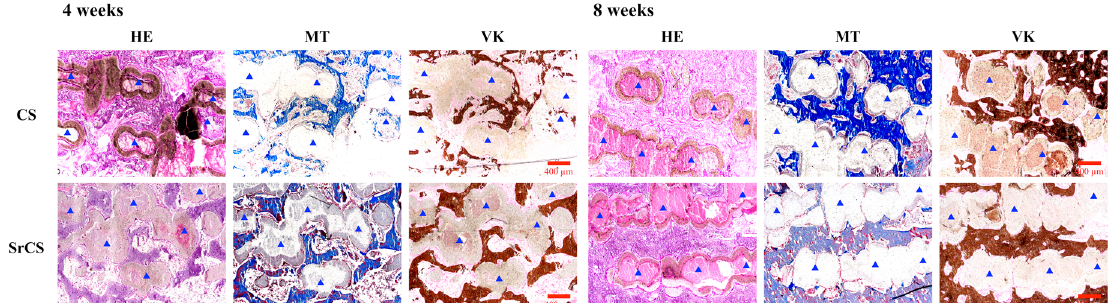
Figure 14. Histological analysis of new bone regeneration around and within the scaffolds in the rabbit femoral defect model. Left: hematoxylin and eosin (HE) stain; Middle: Masson’s trichrome (MT) stain; Right: Von Kossa (VK) stain of regenerated bone mass after 4- and 8-weeks of regeneration of in vivo experiment. The blue triangle indicated the scaffolds. The scale bar is 400 µm.